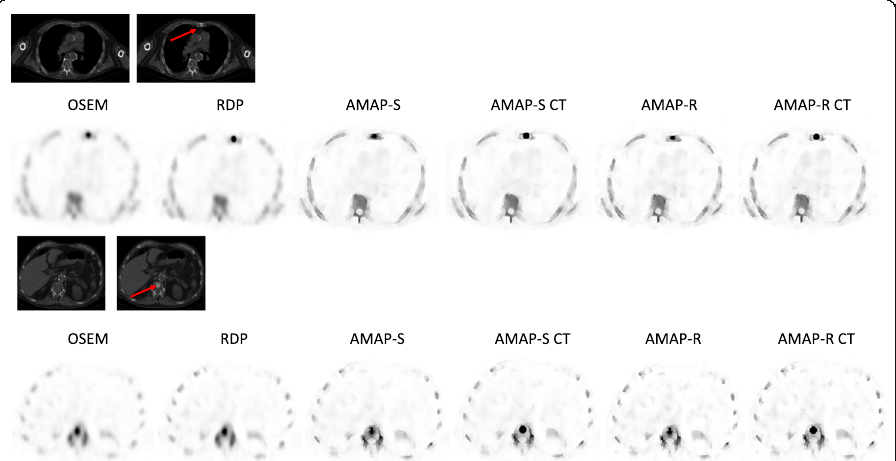
Fig. 2 Example reconstructed SPECT and CT (with and without lesions) transverse slices at the level of sternum and spine lesions of the male patient study with artificial lesions. Red arrows show the lesion locations. VOI used to analyze the reconstructed SPECT studies had the same shape and position as the lesion seen on the CT image. AMAP-S and AMAP-R refer to reconstructions where lesion is absent in the CT and AMAP-S CT and AMAP-R CT to lesion-present cases. The color scale is set to SUV 15 for all